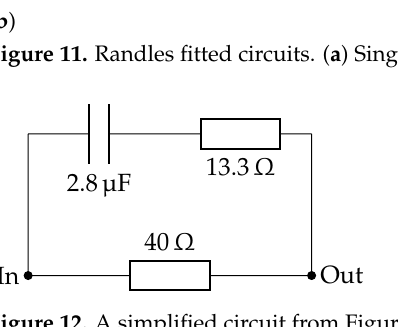
Figure 12. A simplified circuit from Figure